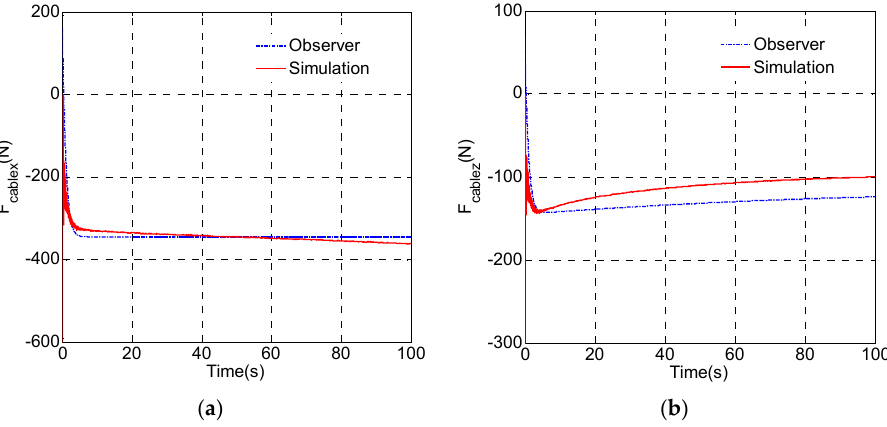
Figure 25. Cable disturbing force: ( a ) cable force in the X direction; ( b ) cable force in the Z direction.